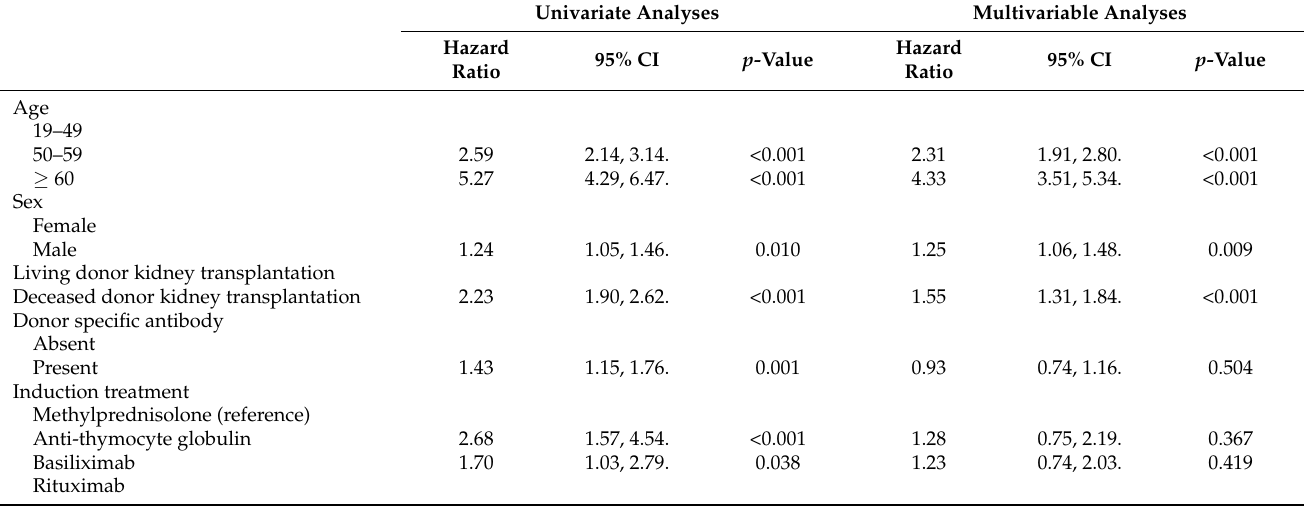
Table 4. Cox regression analysis for death after kidney